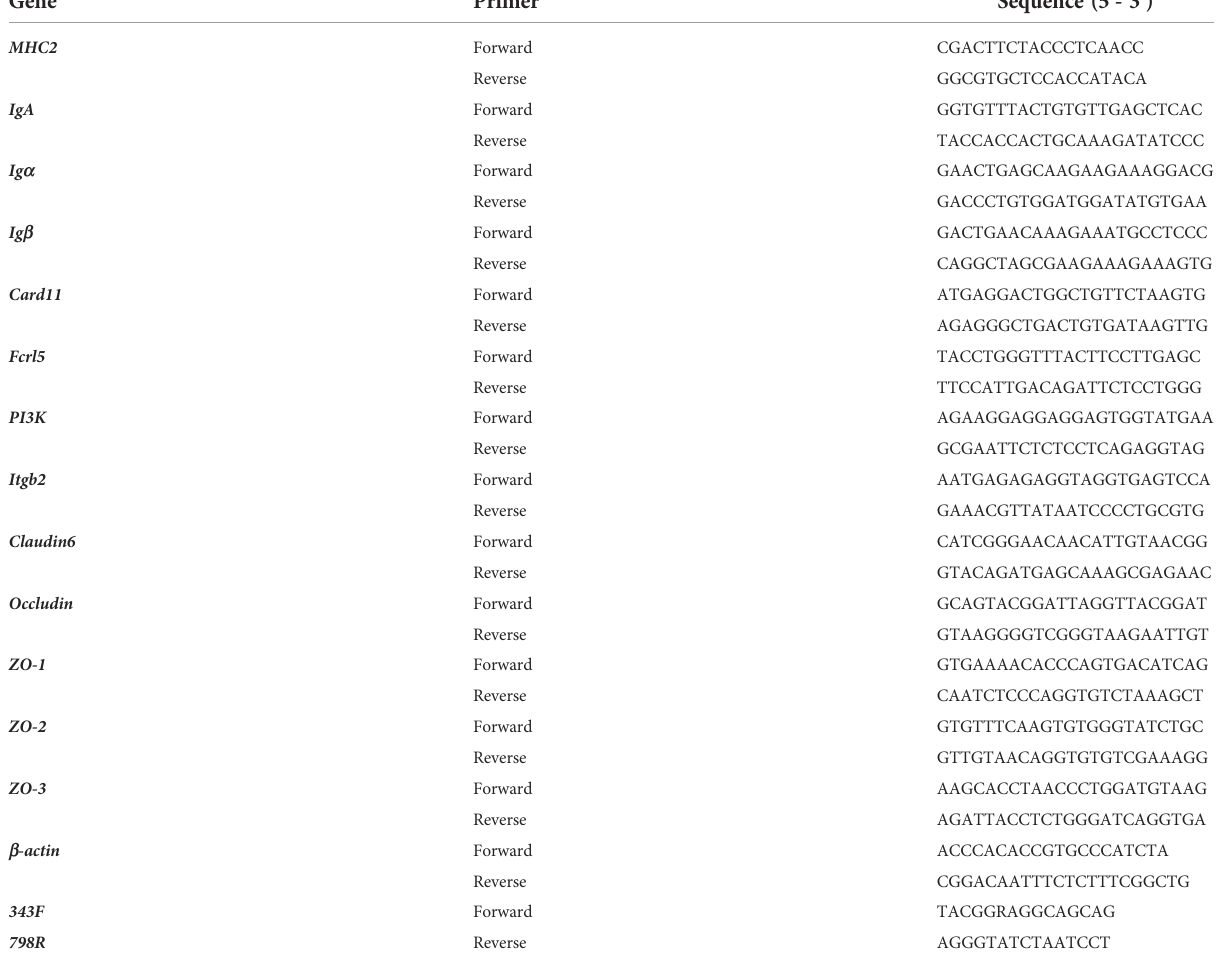
TABLE 1 Primer sequences for real-time PCR